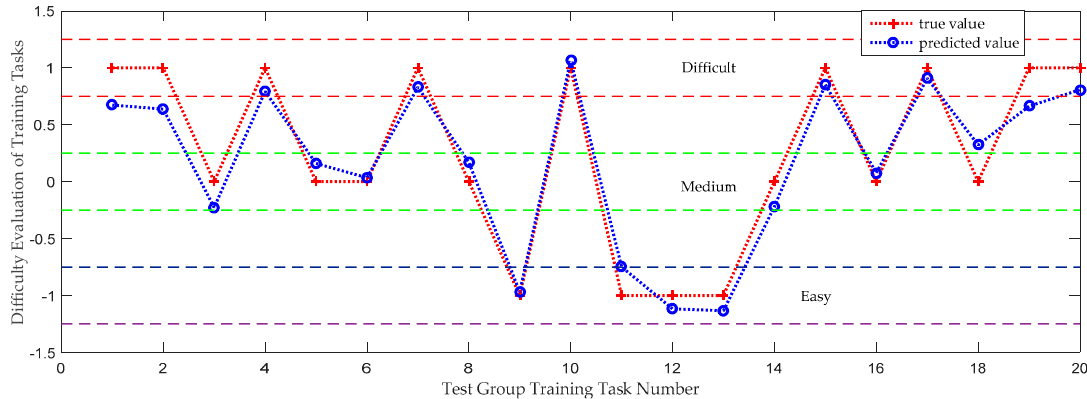
Figure 12. Comparison between task difficulty prediction and reality of test group.